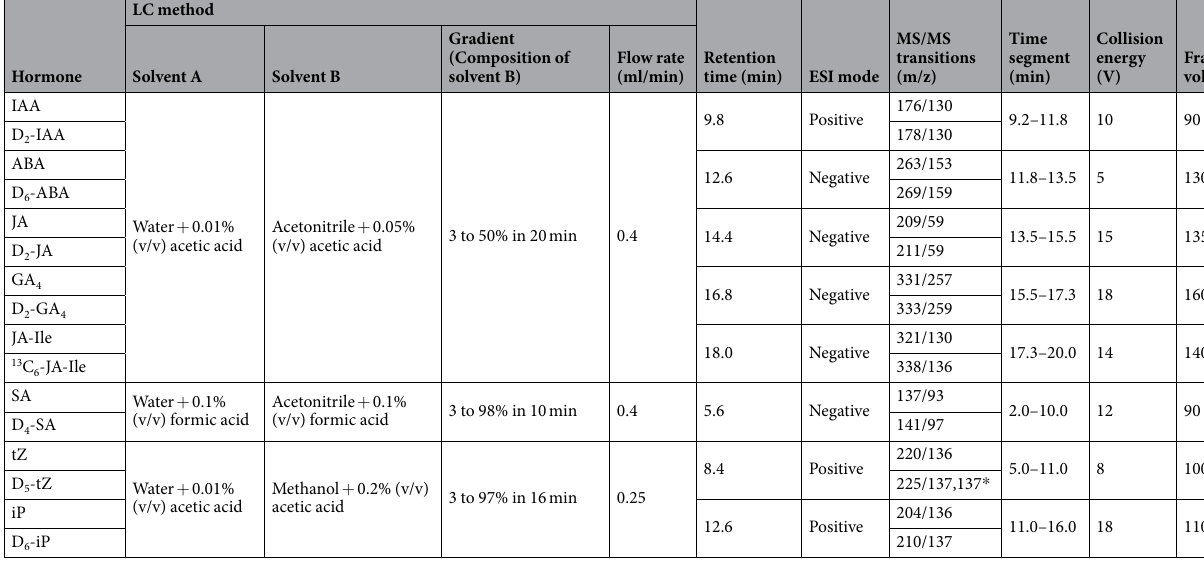
Table 1. Details of parameters used for LC-ESI-MS/MS analysis of abscisic acid (ABA), jasmonic acid (JA), jasmonoyl-isoleucine (JA-Ile) and salicylic acid (SA), indoleacetic acid (IAA), trans -zeatin (tZ), isopentenyladenine (iP) and gibberellin A 4 (GA 4 ). * Two fragment